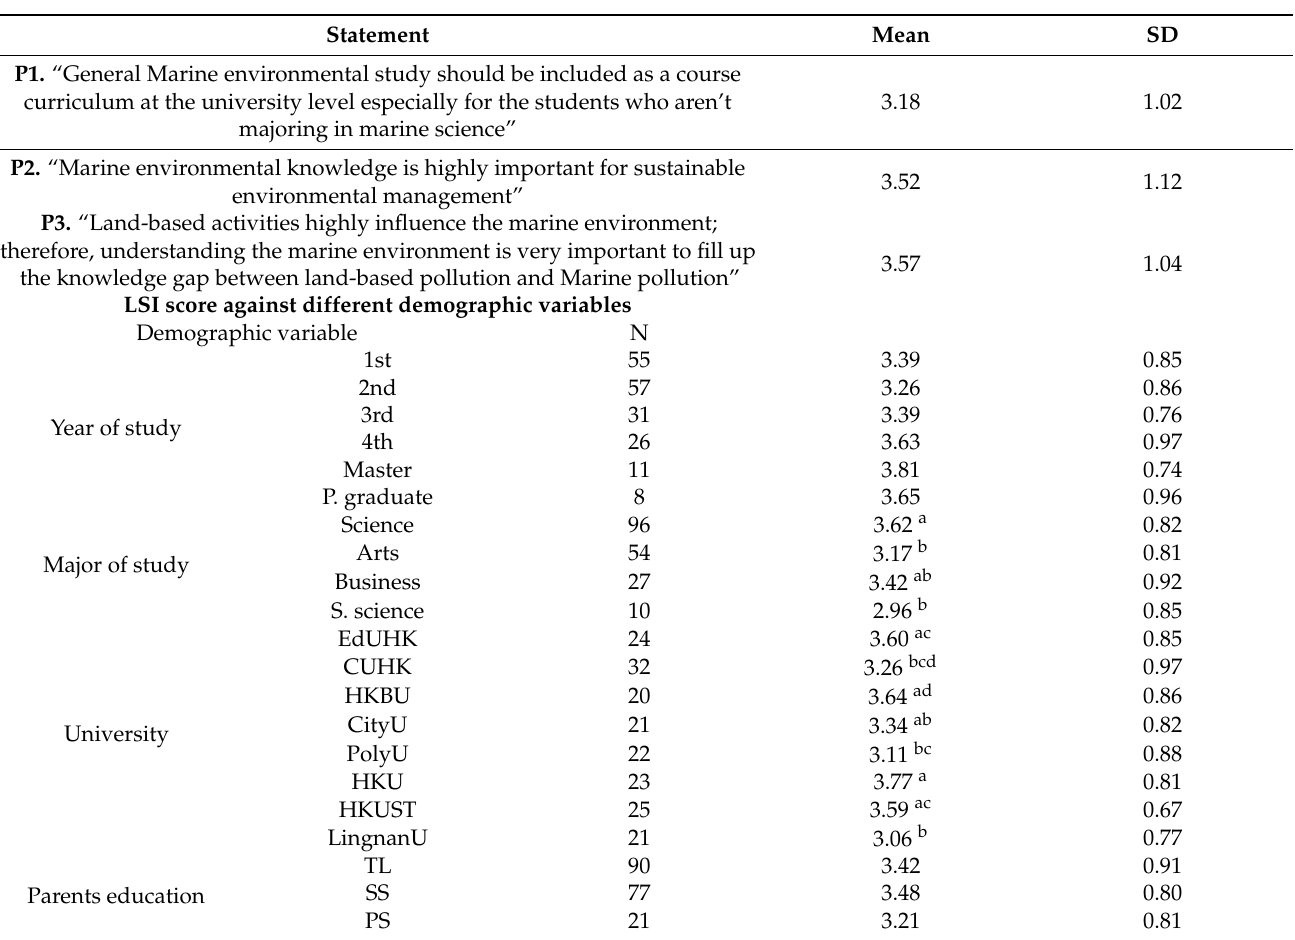
Table 7. Mean scores of three statements related to land–sea interaction (LSI) and inclusion of marine study